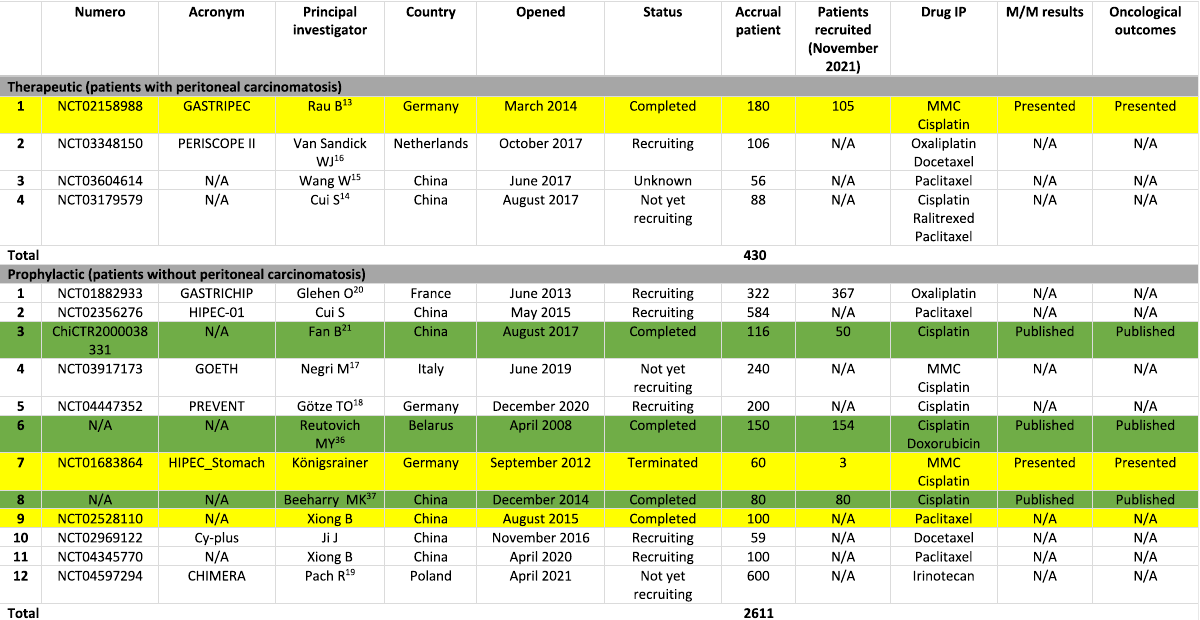
Table  : Prospective randomized trials evaluating CRS and HIPEC in gastric